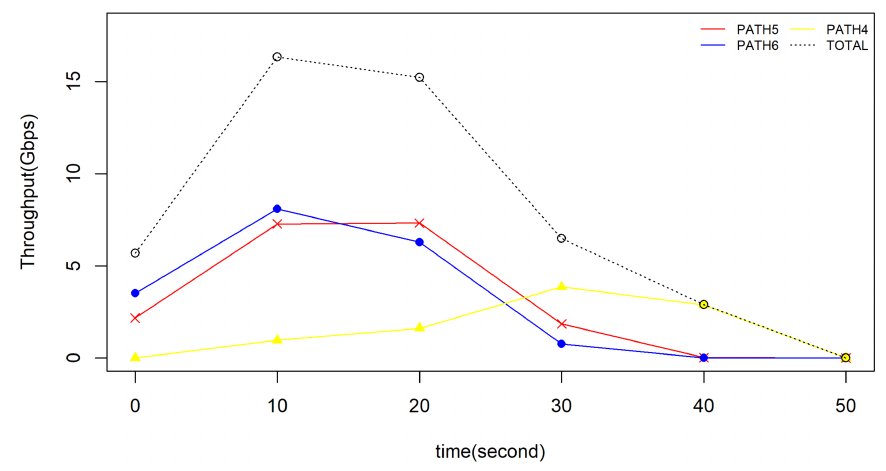
Figure 11. Throughput when five servers write